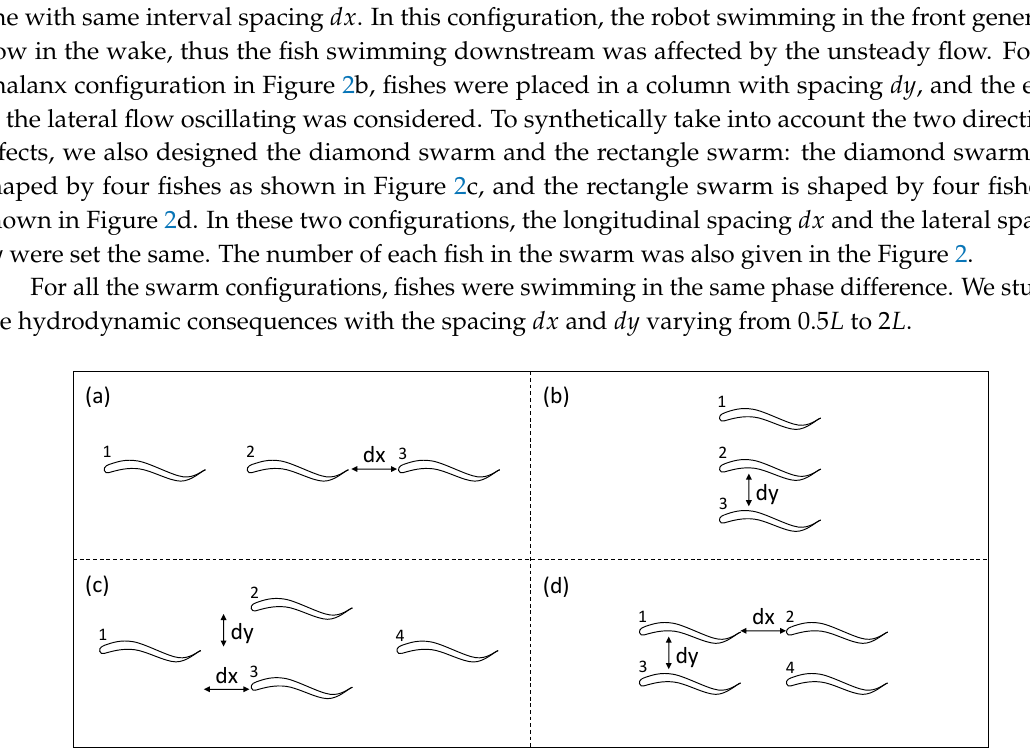
Figure 2. Graphical representation of the swarm configurations: ( a ) tandem, ( b ) phalanx, ( c ) diamond and ( d ) rectangle. Lateral spacing between neighbours is given by dy and longitudinal spacing by dx